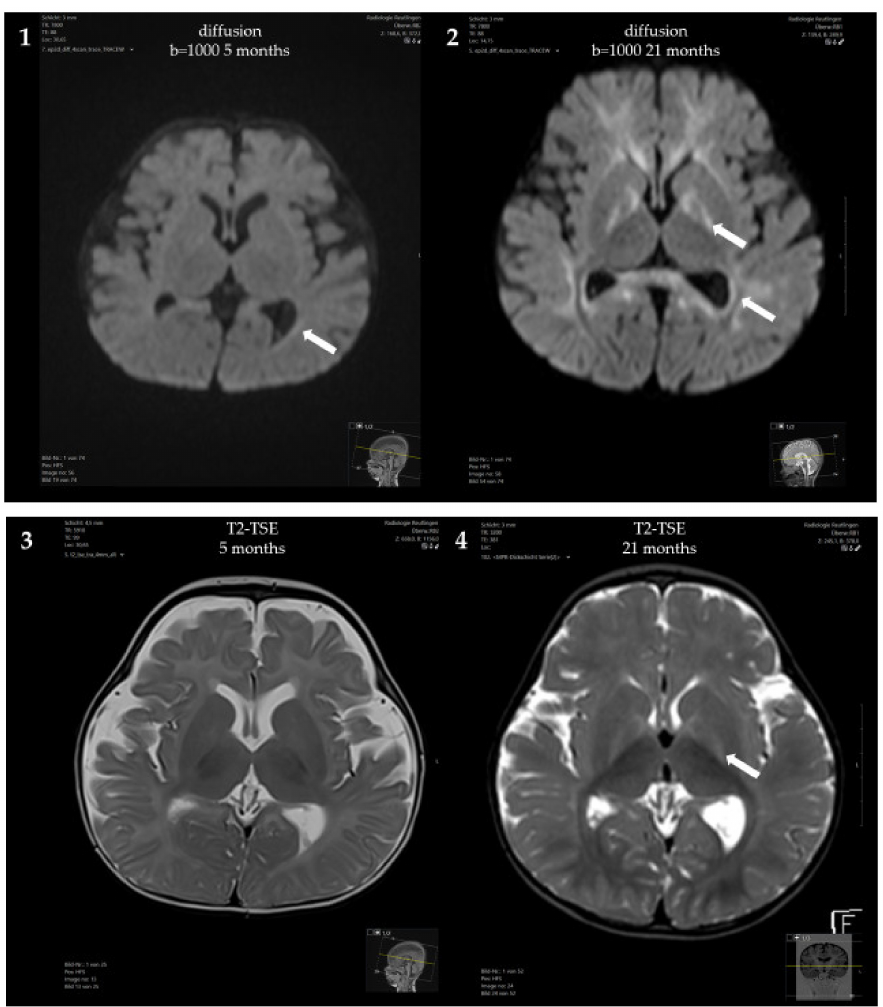
Figure 2. Brain MRI of the patient: ( 1 , 3 ) At 5 months, showing mildly delayed myelination, dilated inner and outer cerebrospinal fluid spaces and mild periventricular diffusion interference; ( 2 , 4 ) At 21 months, showing progressive diffusion